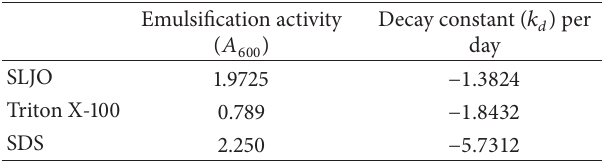
Table 4: Emulsification activity and stability of SLJO and synthetic